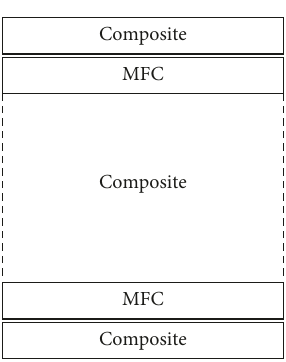
Figure 2: The layers of the composite panel with embedded MFC